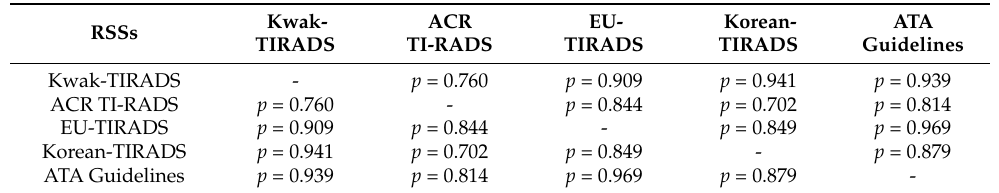
Table 5. Comparison of Area under the Curve (AUC) values between the investigated risk stratifica- tion systems (RSSs) via Hanley and McNeil Test